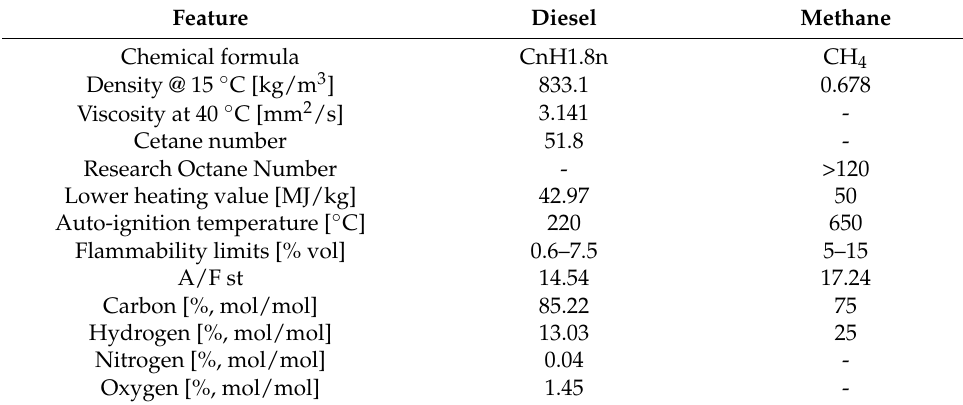
Table 8. Chemical and physical properties for diesel and methane fuels.